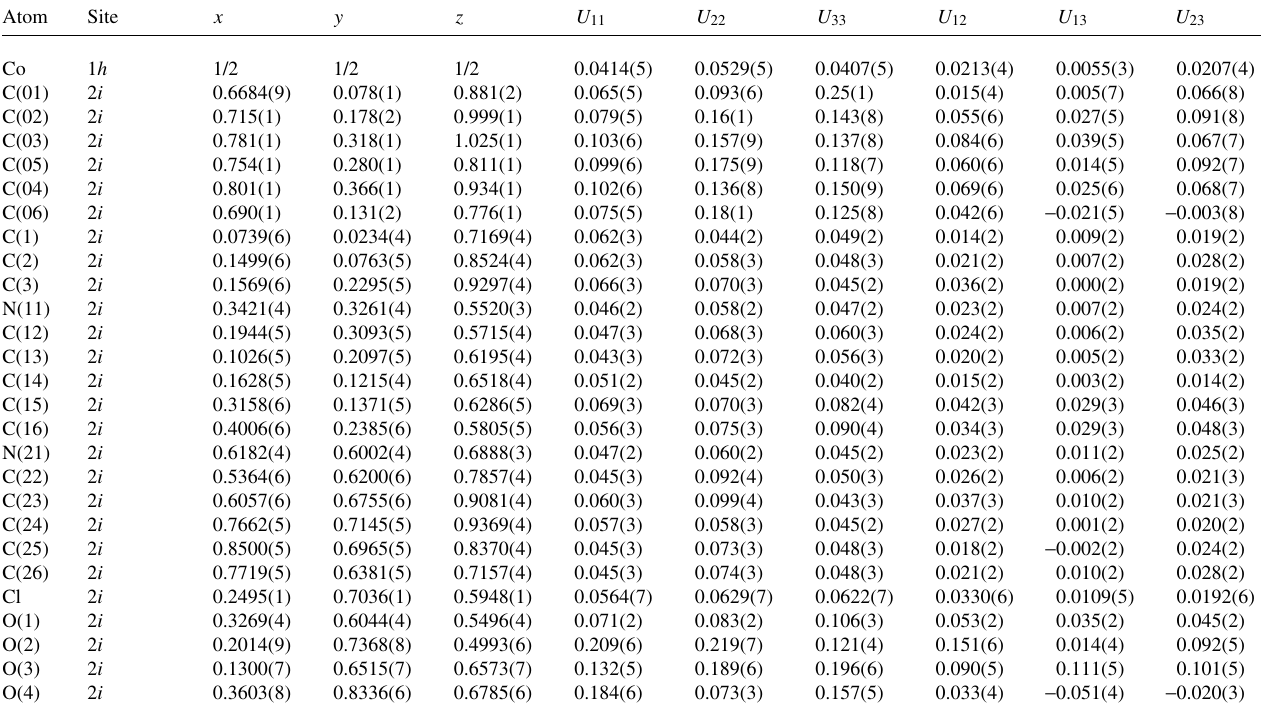
Table 3. Atomic coordinates and displacement parameters (in Å 2 ) .